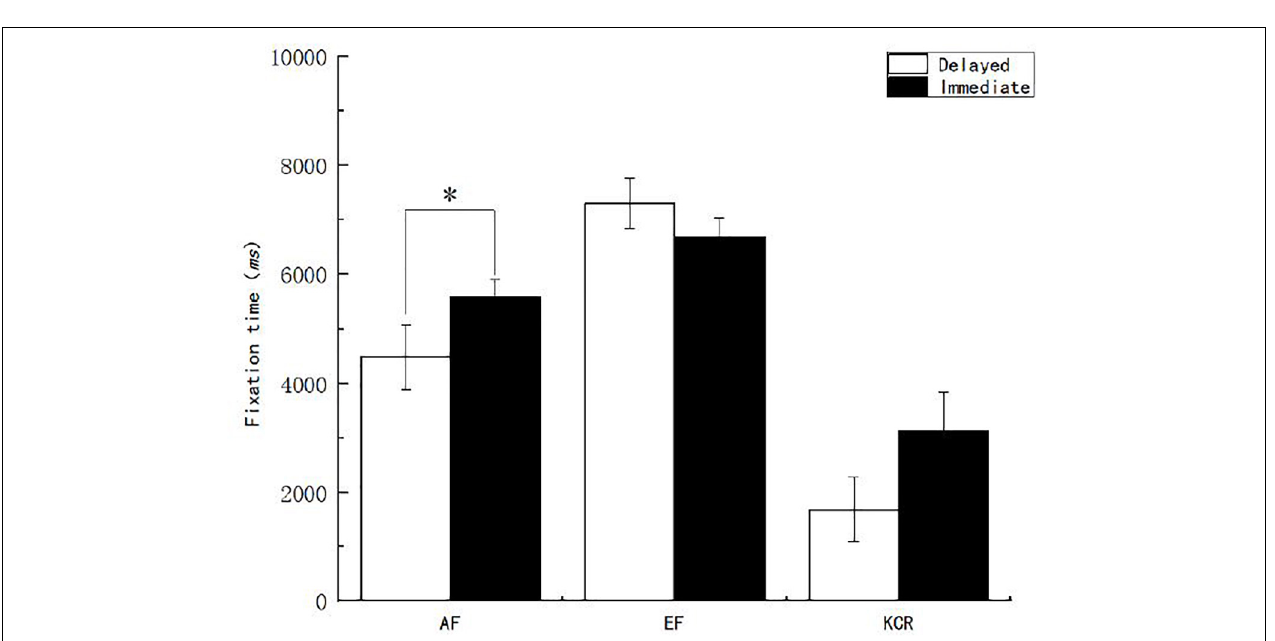
FIGURE 7 | Fixation count of learners on the feedback interest area under different feedback conditions. *Significant correlation at the level of 0.05 (bilateral).